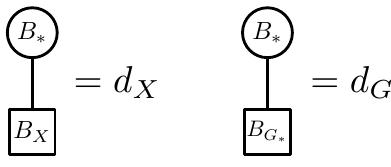
Figure 6: Set-decorated constraints aligning the parts contained in B ∗ . The value of X ranges among A ,..., F , P , Q , R , and the value of d Z in the graphon (cid:101) W Z is equal to the degree of the part (cid:101) 0 where Z ∈ { A ,..., G , P , Q , R } .